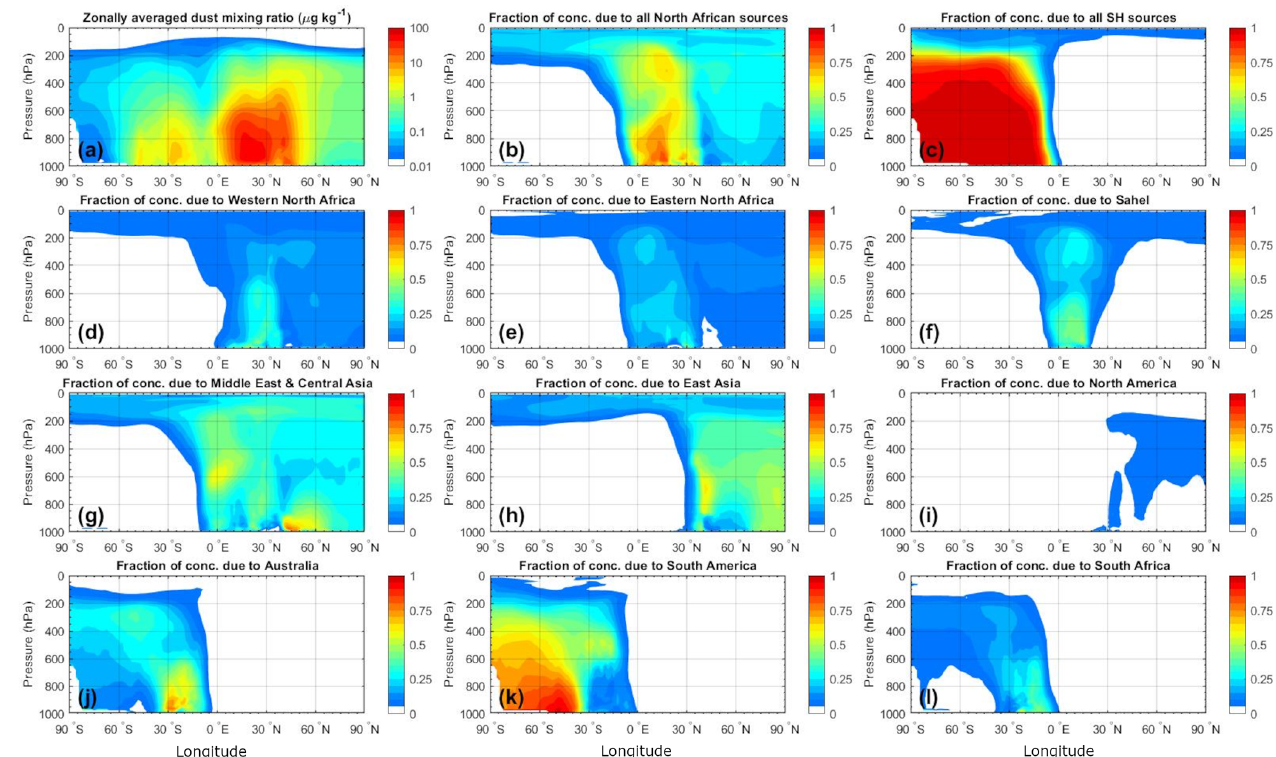
Figure 6. Attribution of the zonally averaged and annually averaged PM 20 dust concentration to the world’s main source regions. Panel (a) shows the zonally averaged dust mixing ratio (dust concentration normalized by air density) as a function of latitude (horizon- tal axis) and pressure (hPa; vertical axis). Panels (b) – (l) show the partition of the dust concentration per source region, with panel ordering identical to Fig. 5. The seasonally resolved attribution of the zonally averaged dust concentration is shown in Figs.